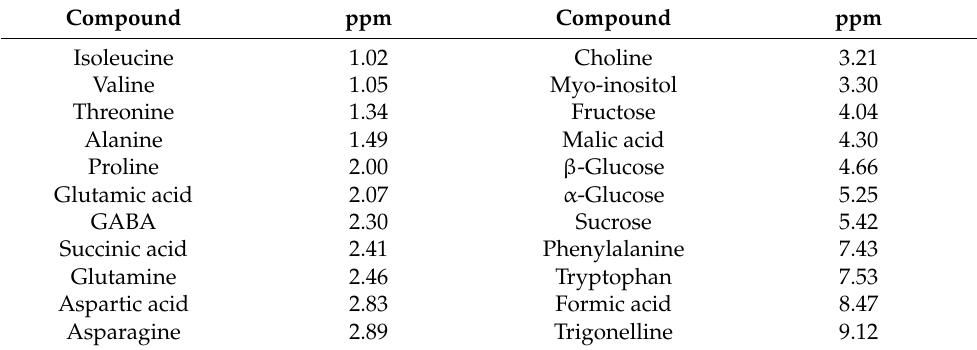
Table 4. Compounds, with relative 1 H NMR signals (ppm), quantified in Cannabis sativa L. inflores- cences Bligh–Dyer hydroalcoholic extracts. Analyses were carried out in